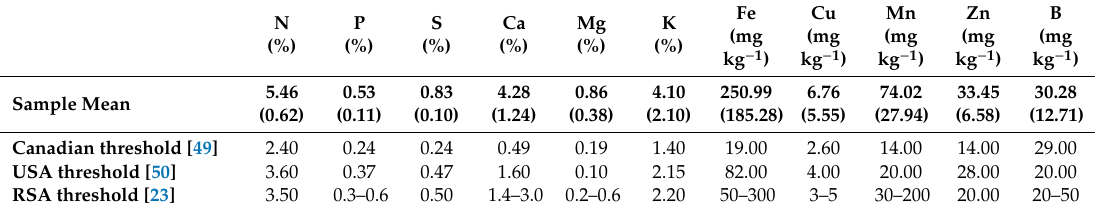
Table 9. Sample means of analysed canola leaf nutrients in comparison with the Canadian, USA, and South African (RSA) threshold values for each nutrient. n = 15; standard deviation is indicated in